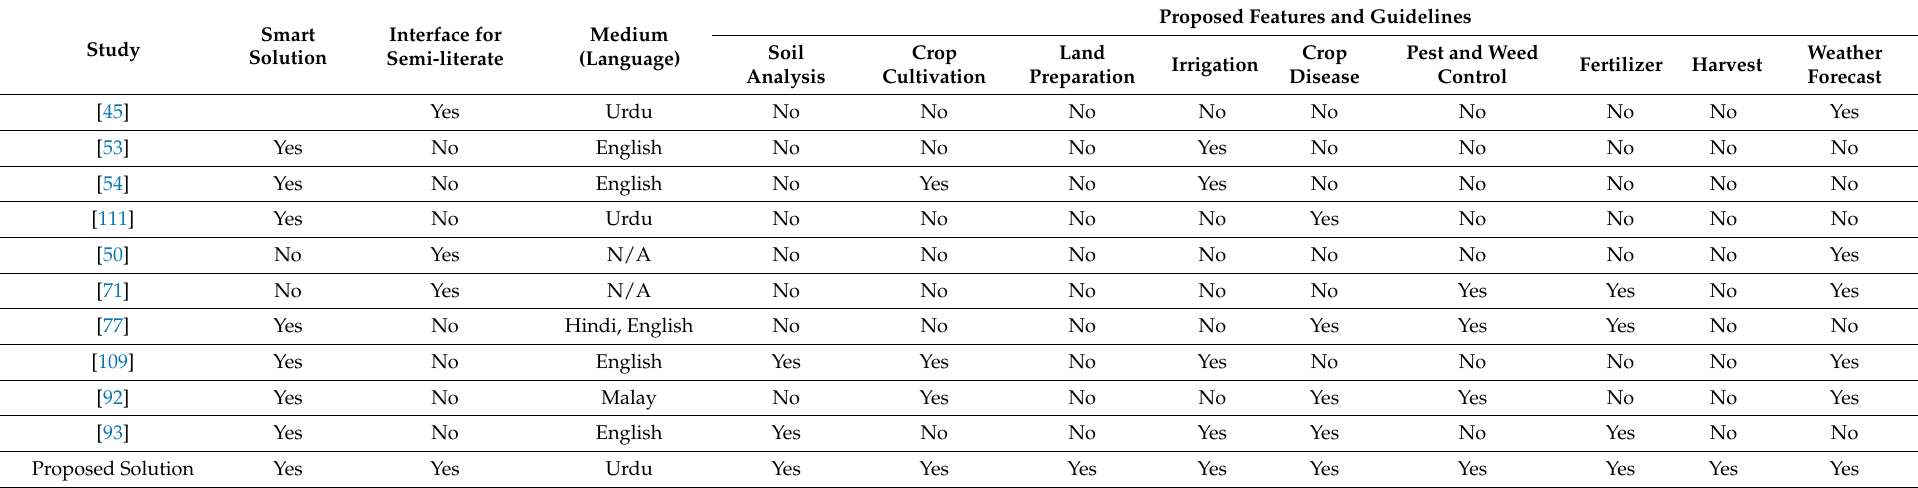
Table 4. Comparison summary of related studies vs. proposed